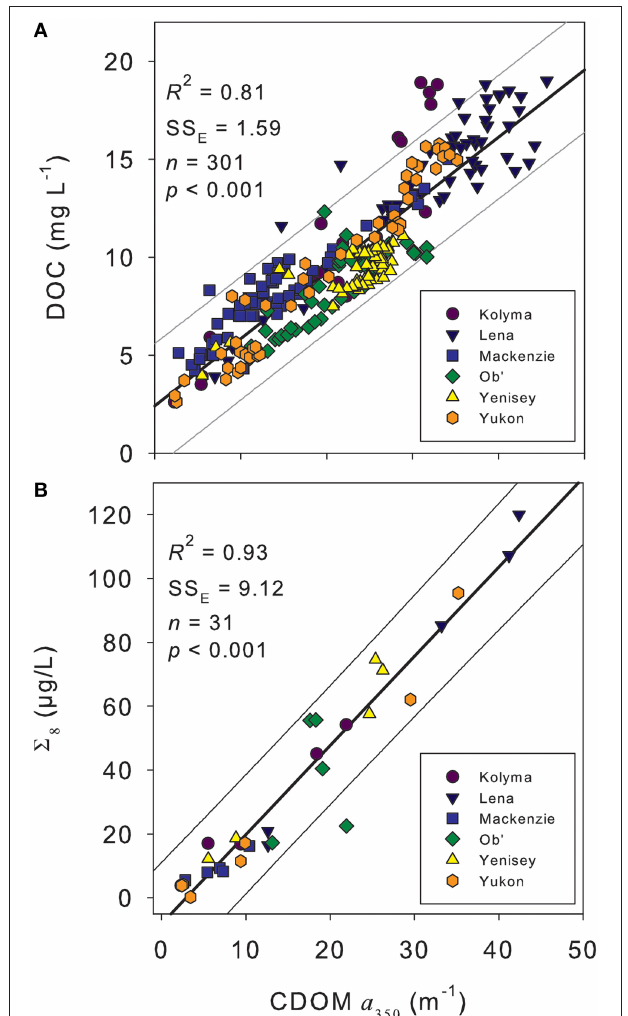
FIGURE 3 | (A) Dissolved organic carbon (DOC) concentration vs. the CDOM absorbance coefficient at 350nm ( a 350 ) from across the hydrograph of the six Arctic rivers. (B) Lignin phenol concentration ( 6 8 ) vs. a 350 from across the hydrographs of the six Arctic rivers. Thick black line represents the linear regression of the data. Thin gray lines represent the extent of the prediction of fit (95% confidence limit). SS E indicates the error of estimate providing an indication of variation around the